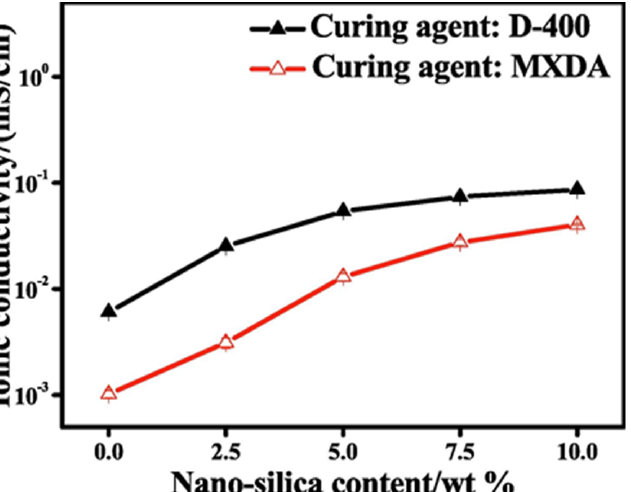
Figure 6. Ambient temperature ionic conductivity of polymer electrolytes comprised of DGEBA, PEG, LiTf and nano-silica using either Jeffamine D400 or metaxllenediamine (MXDA) as a curing agent. The lithium to ether oxygen ratio was 0.125 in all cases. Materials Science and Engineering B, 2017.